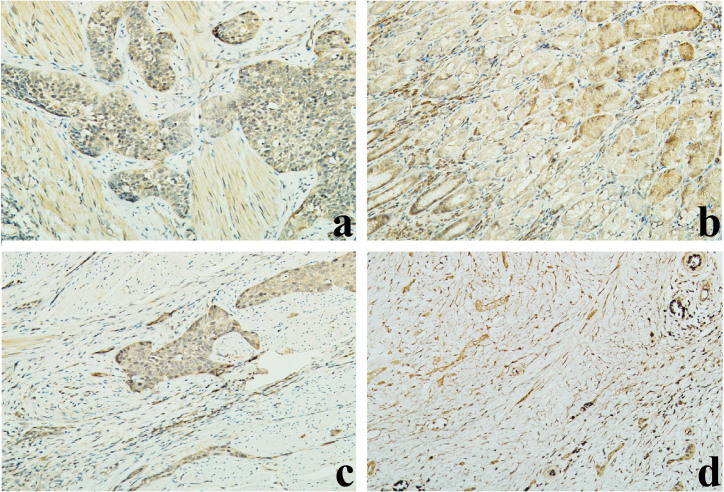
Distribution of IL-23 in patients with OC.Representative images of IL-23 expression in metastatic tumour (a) and precancerous tissue with metastasis (b) by IHC staining (200 × magnification). Representative images of IL-23 expression in primary tumour (c) and precancerous tissue without metastasis (d) by IHC staining (200 × magnification).